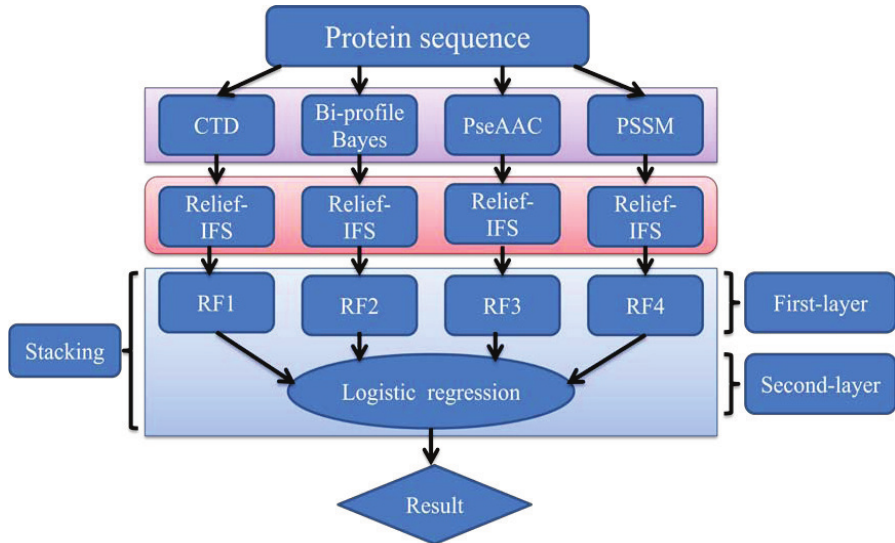
Figure 1. The computational framework of the proposed method. CTD: composition, transition and distribution; PseAAC: pseudo-amino acid composition; PSSM: position-specific scoring matrix; IFS: incremental feature selection; RF: random